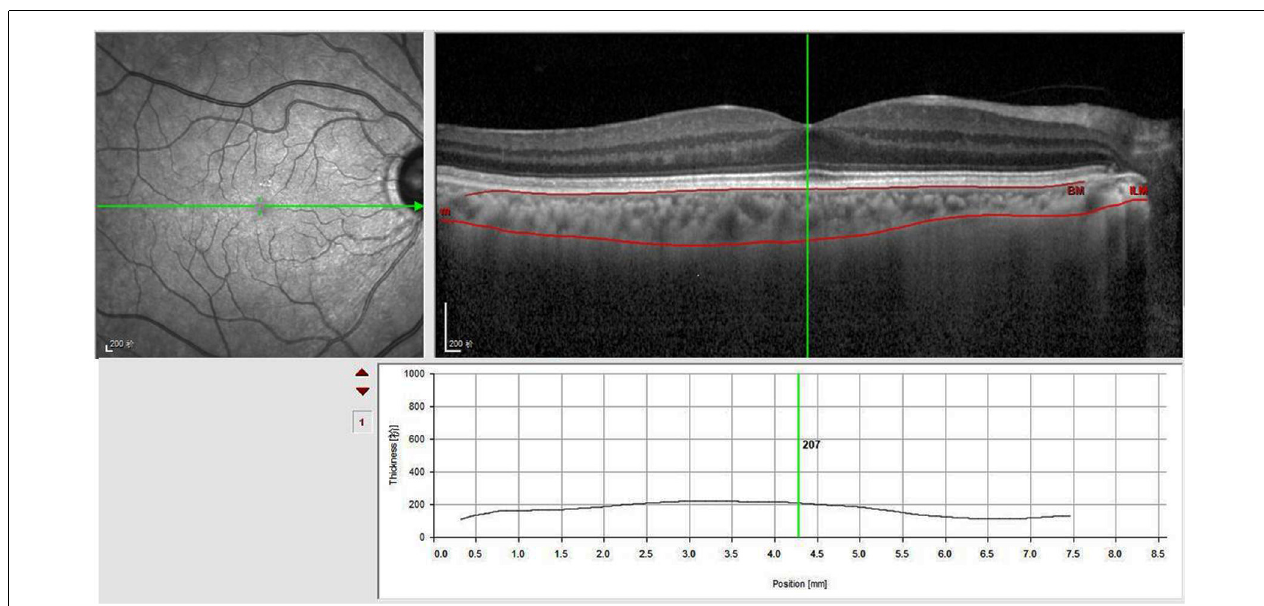
FIGURE 3 | Subfoveal choroidal thickness (SFChT) measurements. Using the analysis software of OCT, manually segmented internal limiting membrane line to the choroidoscleral junction. When we adjusted the vertical line perpendicular to the center of the fovea, SFChT was calculated automatically.